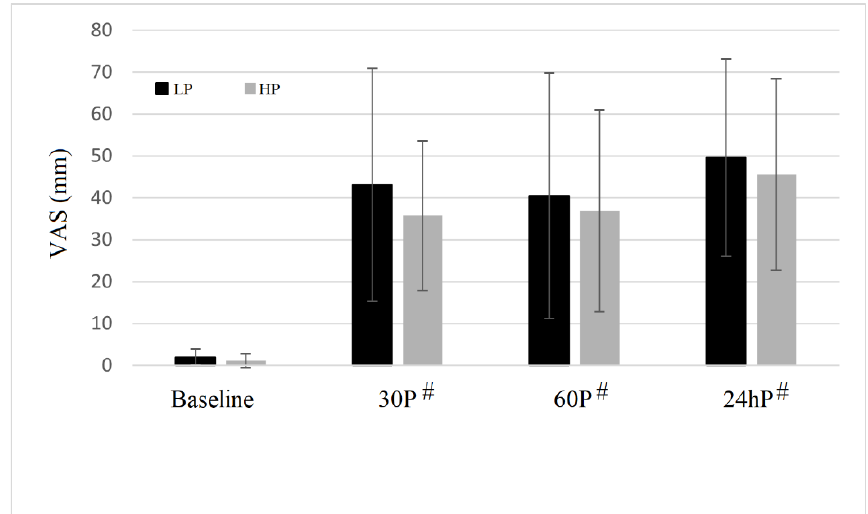
Figure 3. Muscle soreness (VAS = visual analog scale) of biceps brachii muscle at baseline, 30 min (30P), 60 min (60P) and 24 h (24hP) following both high pressure (HP) and low pressure (LP) protocols. # indicates a significantly difference from baseline. Table 1. Data of the maximum isometric force of the elbow flexors measured at the different time- points [baseline, 30 min (30P), 60 min (60P) and 24 h (24hP)] in both HP (high pressure) and LP (low pressure) trial. # indicates a significant difference from